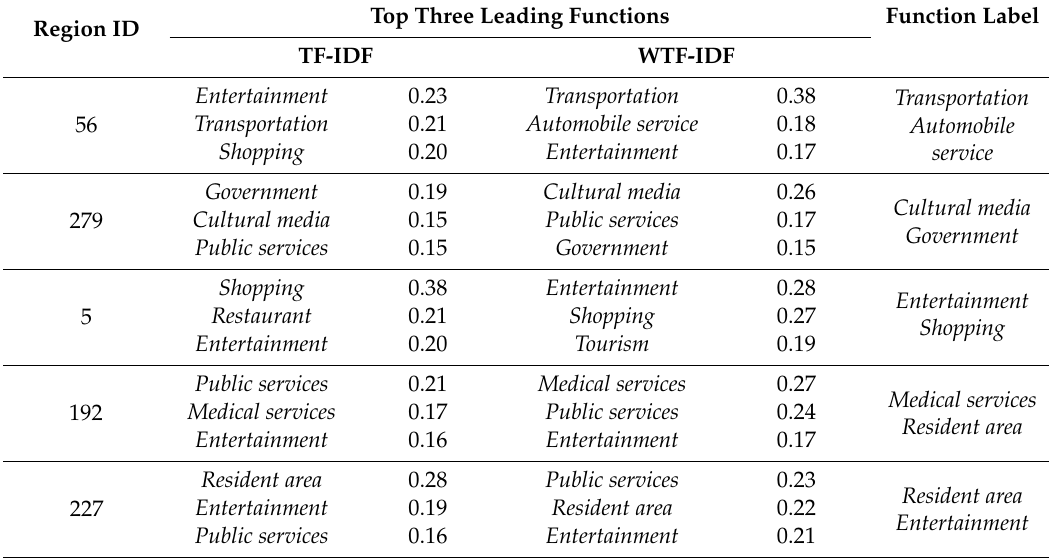
Table 3. The five regions with the smallest cosine similarity between TF-IDF and Weighted TF-IDF (WTF-IDF) and their top three functions.